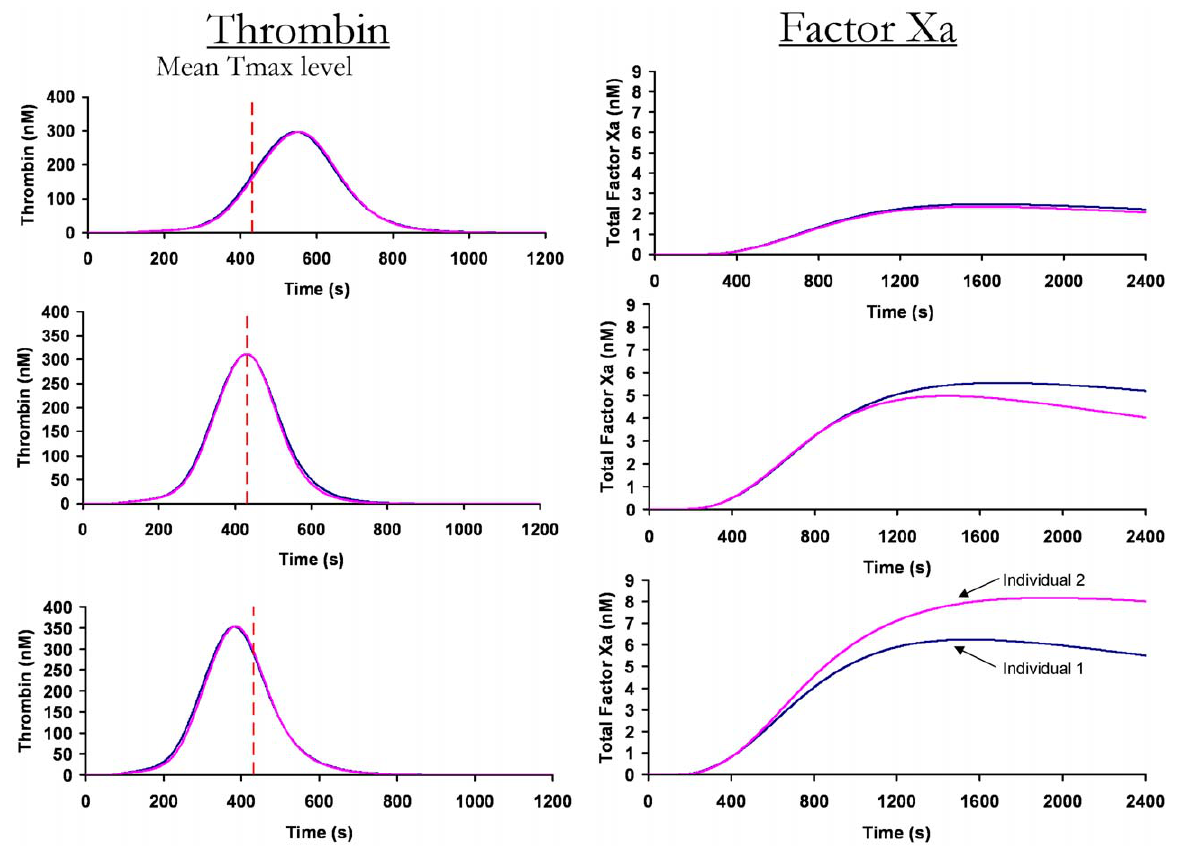
Figure 5. Comparing factor Xa and thrombin generation. Thrombin generation profiles from the same population, previously determined using the same methodology [15], are compared to their fXa profiles. Three pairs of overlapping individual thrombin generation profiles are shown on the left. The dashed line indicates the mean time to the maximum level of thrombin generation within the healthy population (432 s). The corresponding fXa generation profiles in the same individuals are shown on the right.